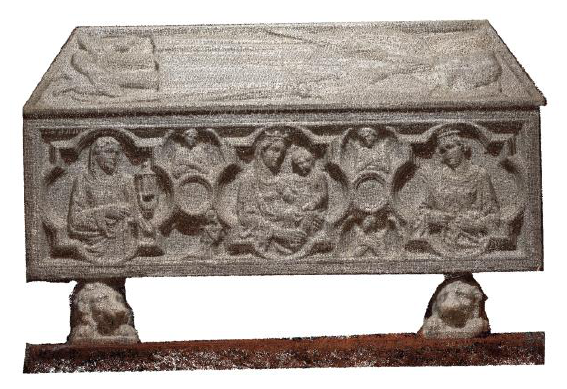
Figure 12. Dense Cloud